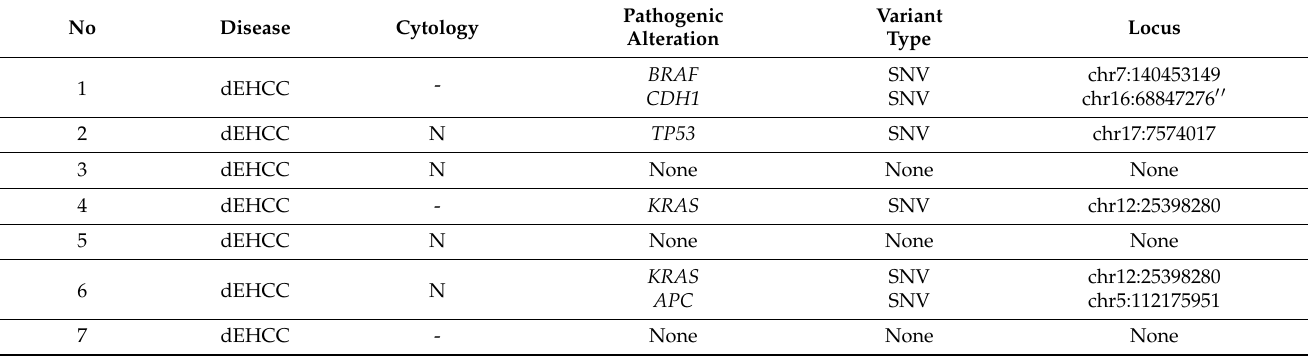
Table 5. Pathogenic alterations in the bile